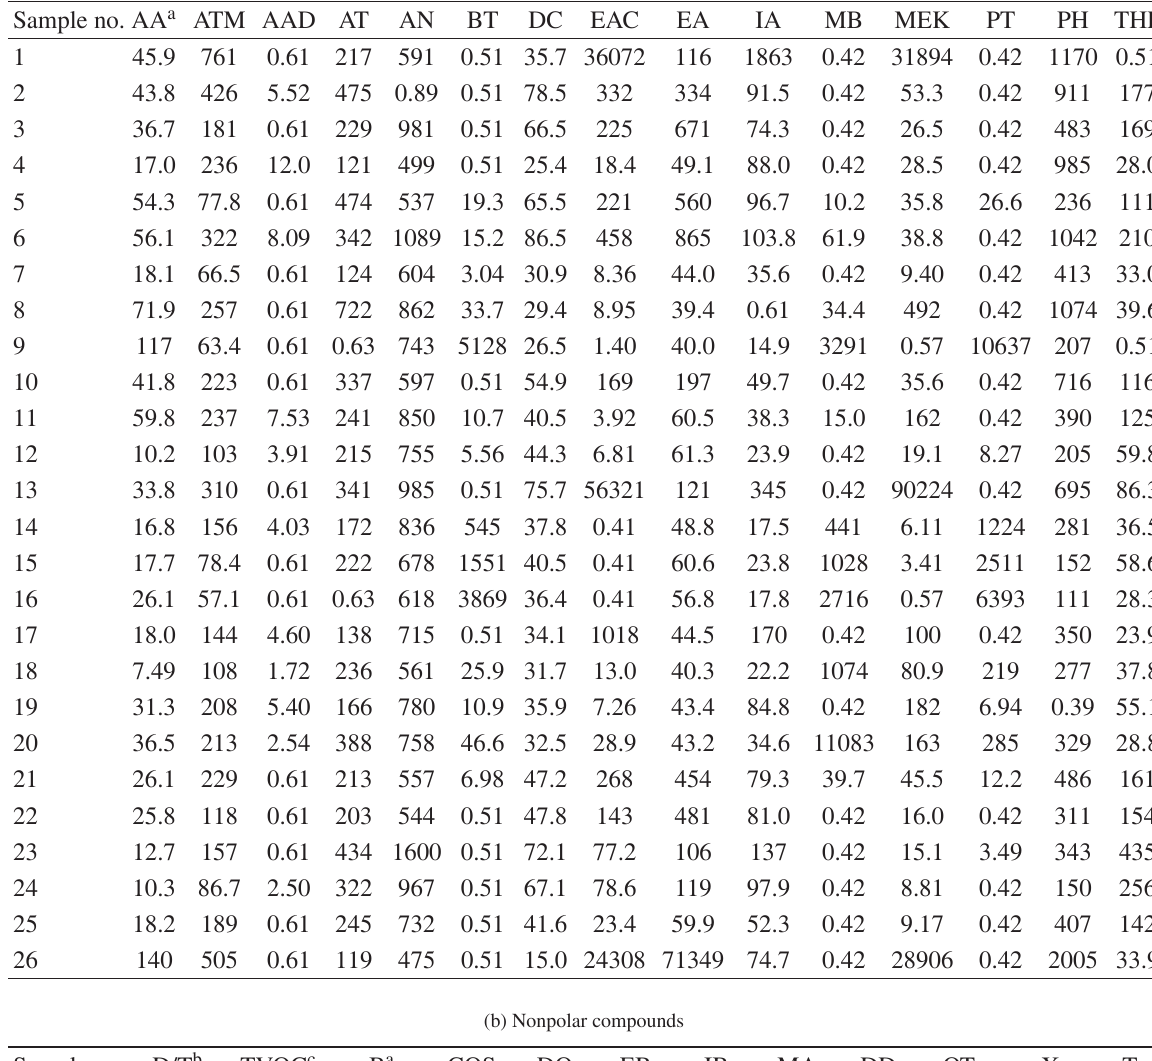
TABLE 2: Concentrations of individual compounds (in ppbC unit) along with TVOC concentration and D/T